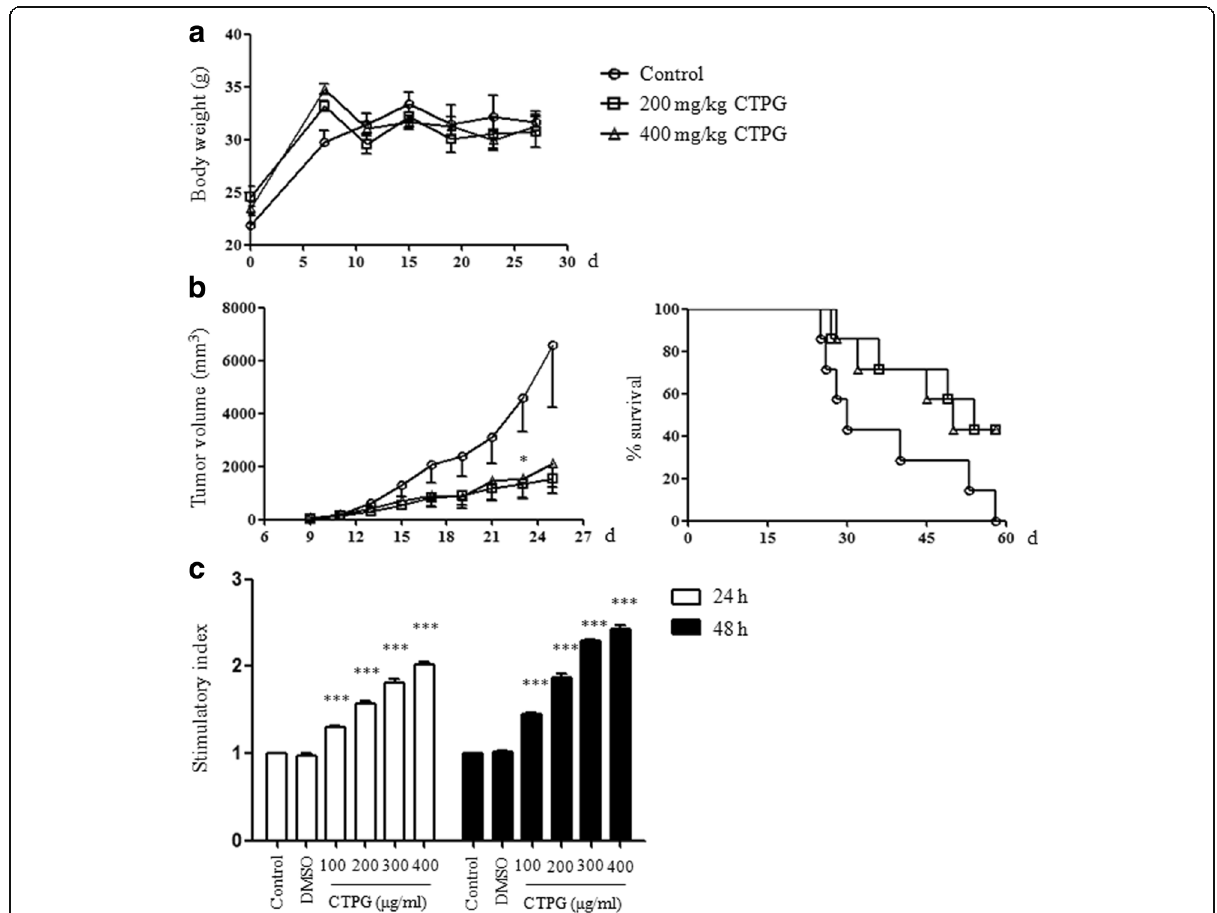
Fig. 6 CTPG suppressed tumor growth in vivo. Tumor mouse model was established by injection of H22 cells. After 3 days, tumor mice (7 mice/ group) were treated with or without CTPG. Body weight of mice ( a ), tumor sizes and survival rate ( b ) were monitored at the indicated time points. ( c ) Splenocytes were isolated from Kunming mice and treated with different concentrations of CTPG for 24 and 48 h. The proliferation of splenocytes was analyzed by MTT. * p < 0.05; *** p < 0.001 compared to